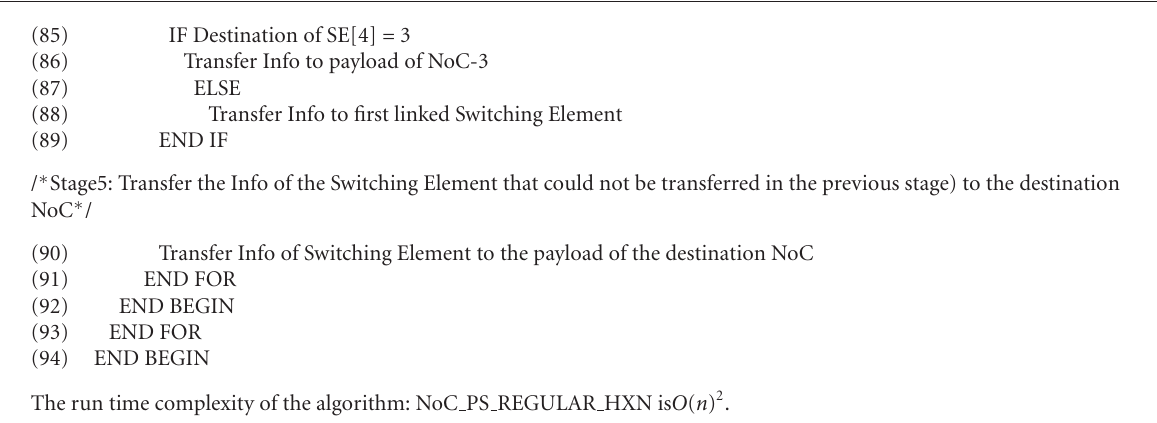
Algorithm 4: NoC PS REGULAR